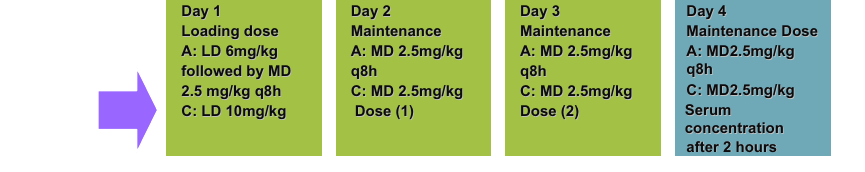
Figure 1: Treatment protocol